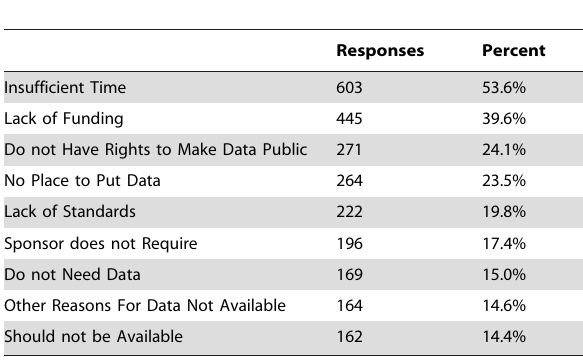
Table 12. Reasons for not making data electronically